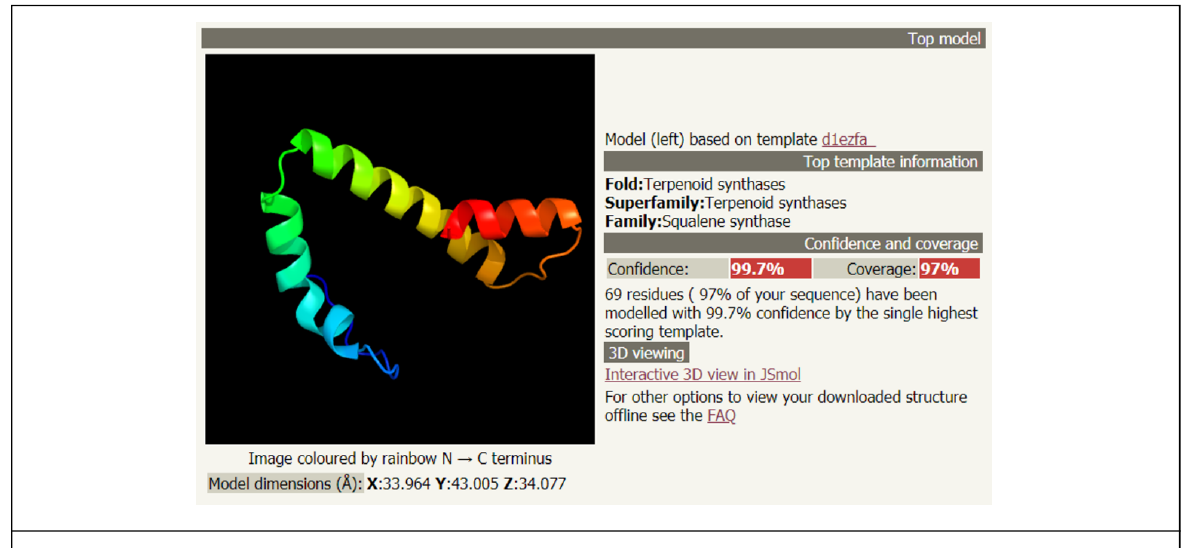
Figure 11: The 3D model of Mc Squlaene Synthase (McSQS) using Phyre2A server